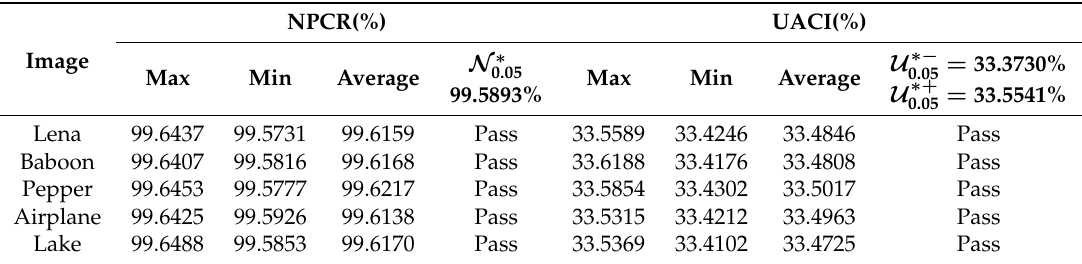
Table 5. The results of number of pixels change rate (NPCR) and unified average changing intensity